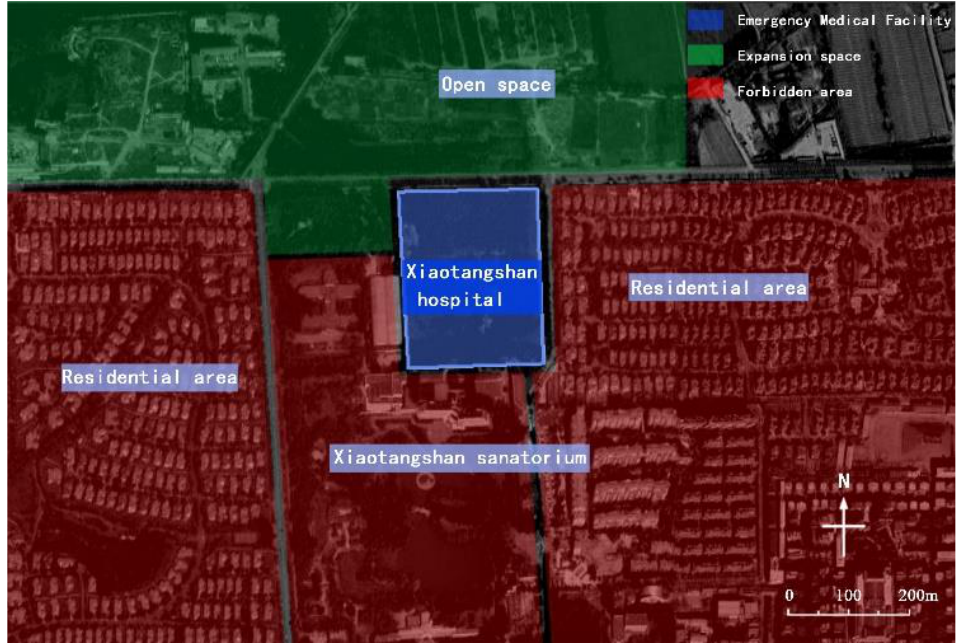
Figure 2. Site environment of Xiaotangshan hospital in 2020.